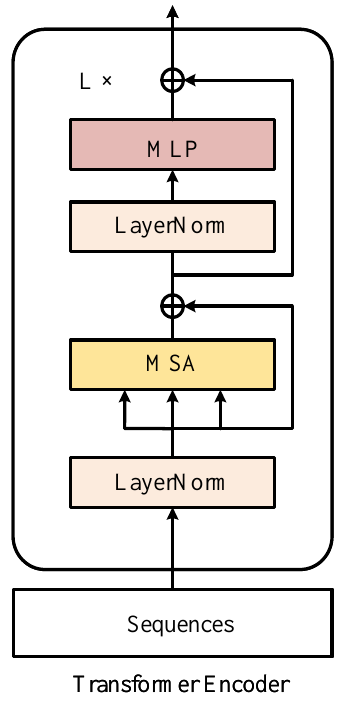
Figure 4. The overall structure of the transformer block.